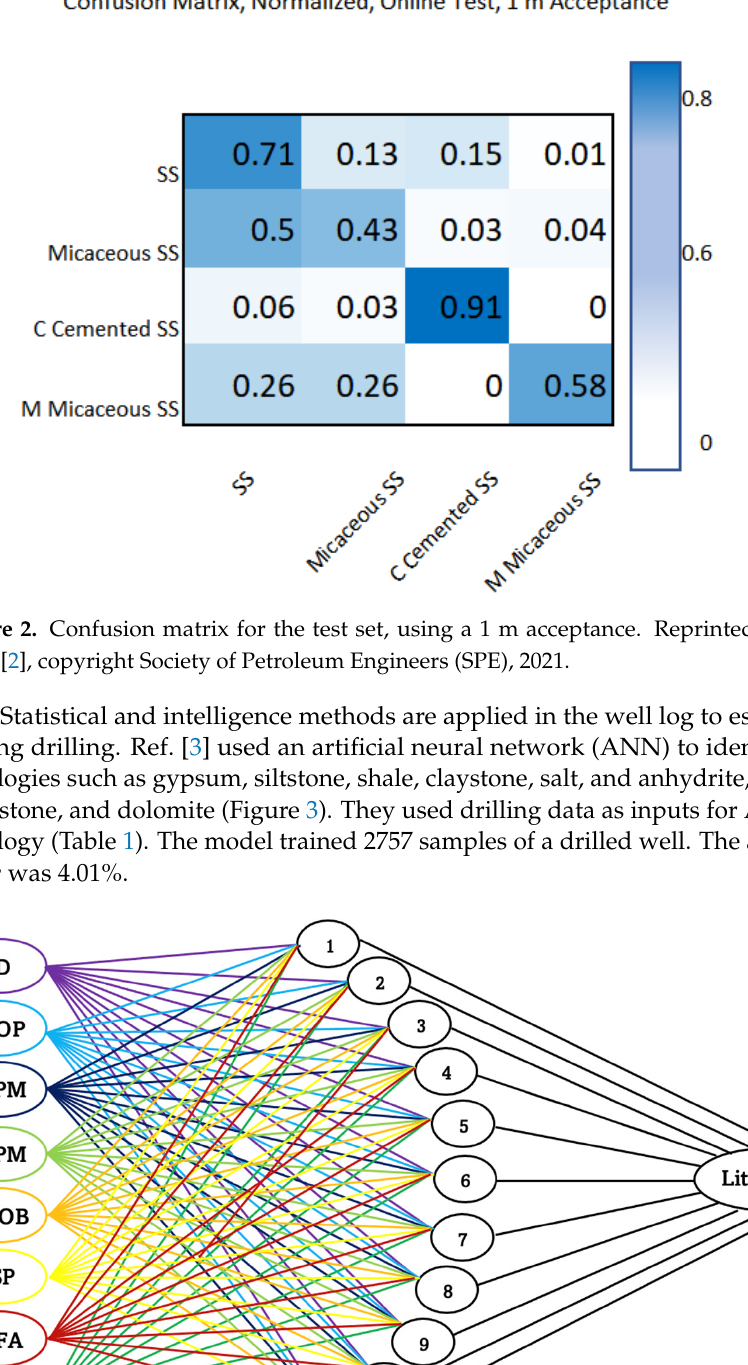
Figure 3. ANN structure.